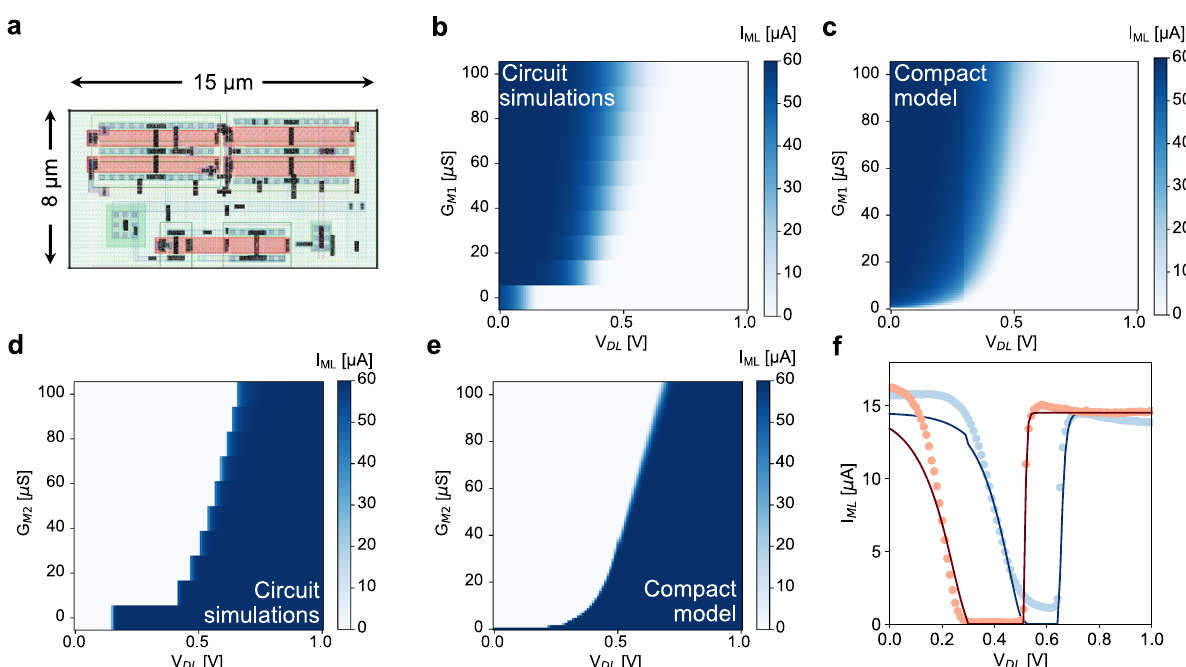
Fig. 2 Analog CAM compact model. a 180 nm cell layout showing the various inputs/outputs. b, c Circuit simulation and model calculation of ML discharge current on the lower threshold branch as a function of V DL and G M 1 . d, e Circuit simulation and model calculation of ML discharge current on the upper threshold branch. f Experimental data (circle) and compact model (lines) for two different ranges stored in analog CAM